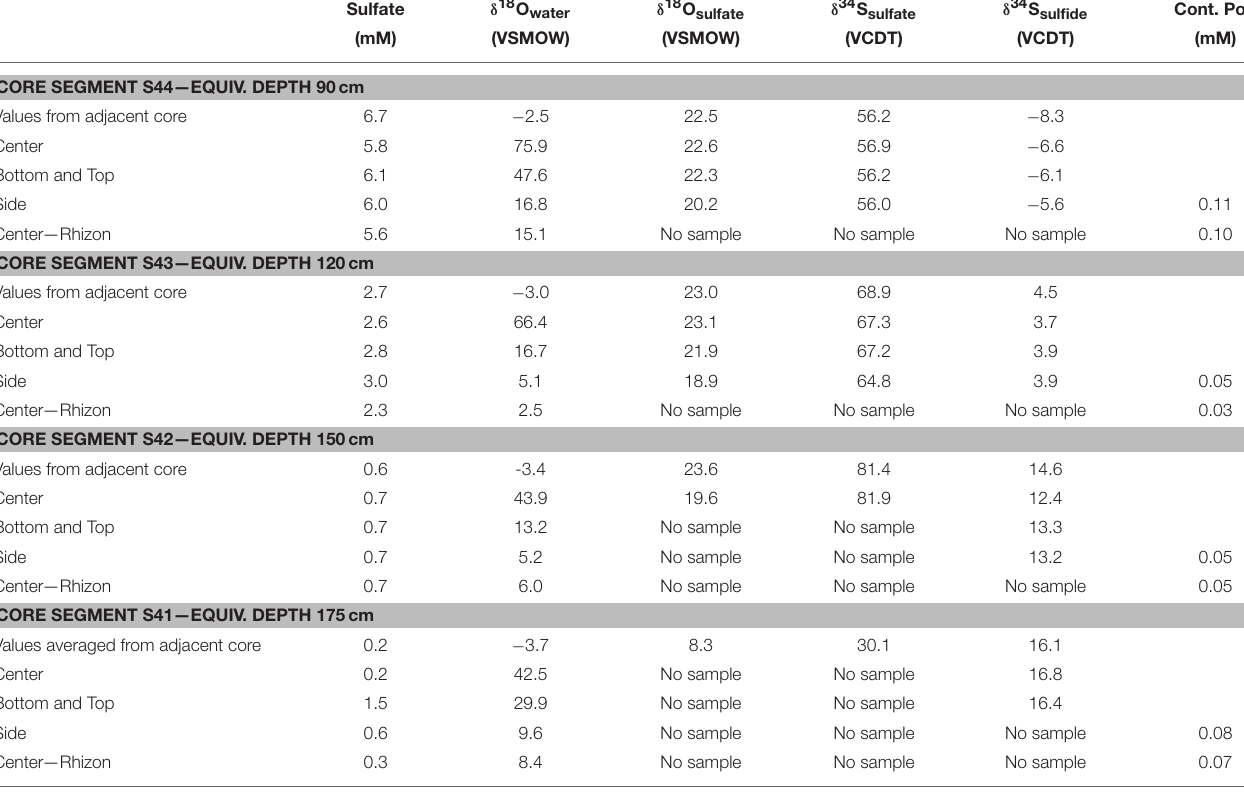
TABLE 4 | Results of sampling artifact experiments.